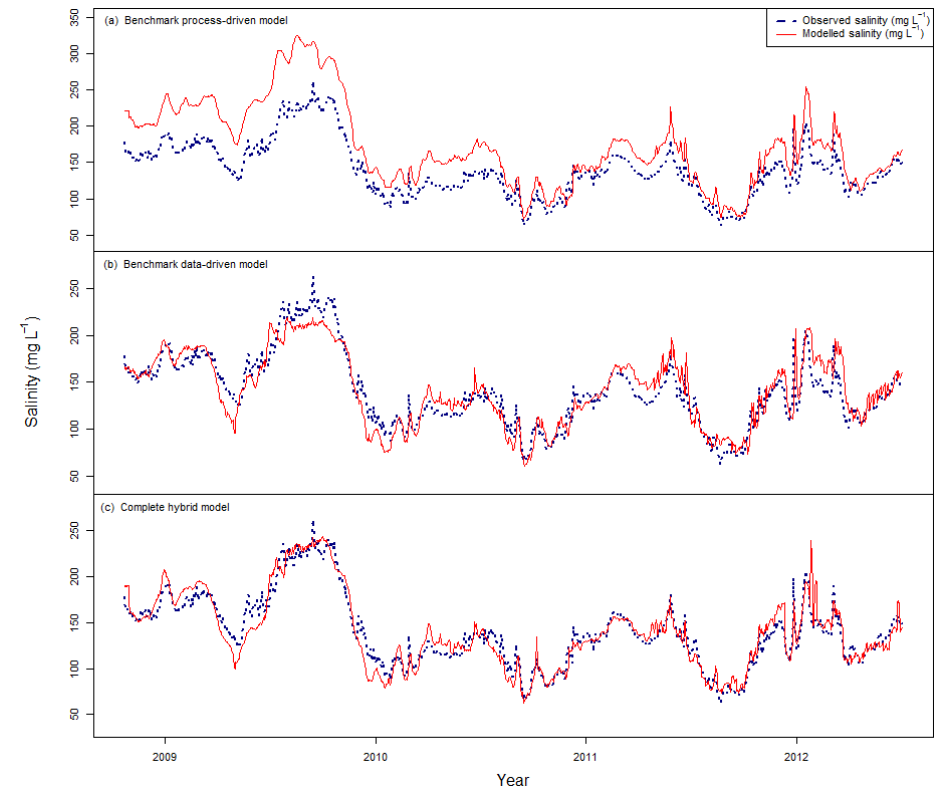
Figure 10. Measured versus modelled salinity at Lock 4 for the hybrid model and the two benchmark models for the validation data.